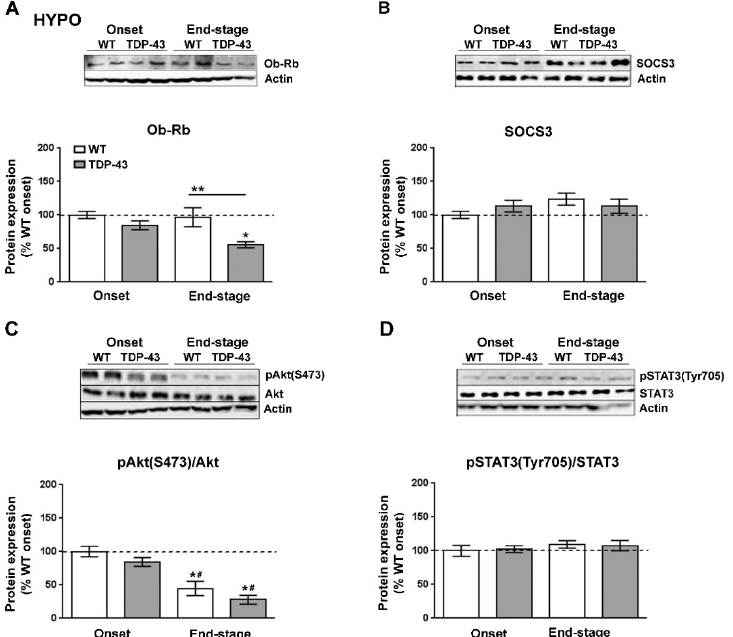
Figure 4. Alterations in serine phosphorylation of Akt in the hypothalamus of TDP-43 A315T mice. Representative actin-normalized immunoblot images and quantitation of ( A ) Ob-Rb receptor, ( B ) SOCS3, ( C ) pAkt (pSer 473 -Akt) protein, ( D ) pSTAT3 (pTyr705-STAT3) proteins, respectively, in hypothalamic extracts of TDP-43 A315T mice compared to age-matched WT littermates at both onset and end-stage of disease. Values are expressed as the mean ± SEM for the different groups (n = 5 per genotype/stage of disease). Comparison between groups was performed by two-way ANOVA followed by Dunnett’s post hoc test to compare all groups with WT onset stage, while Tukey’s post hoc test was used for multiple comparisons between all groups, where * p < 0.05 vs. WT onset stage; # p < 0.05 vs. TDP-43 A315T onset; ** p < 0.05 vs. WT end-staged. In the immunoblot images, representative bands were run on the same gel but were non-contiguous. Abbreviations: HYPO, hypothalamus; Ob-Rb, long form of leptin receptor; SOCS3, suppressor of cytokine signaling 3; Akt, serine / threonine kinase; STAT3, signal transducer and activator of transcription 3.